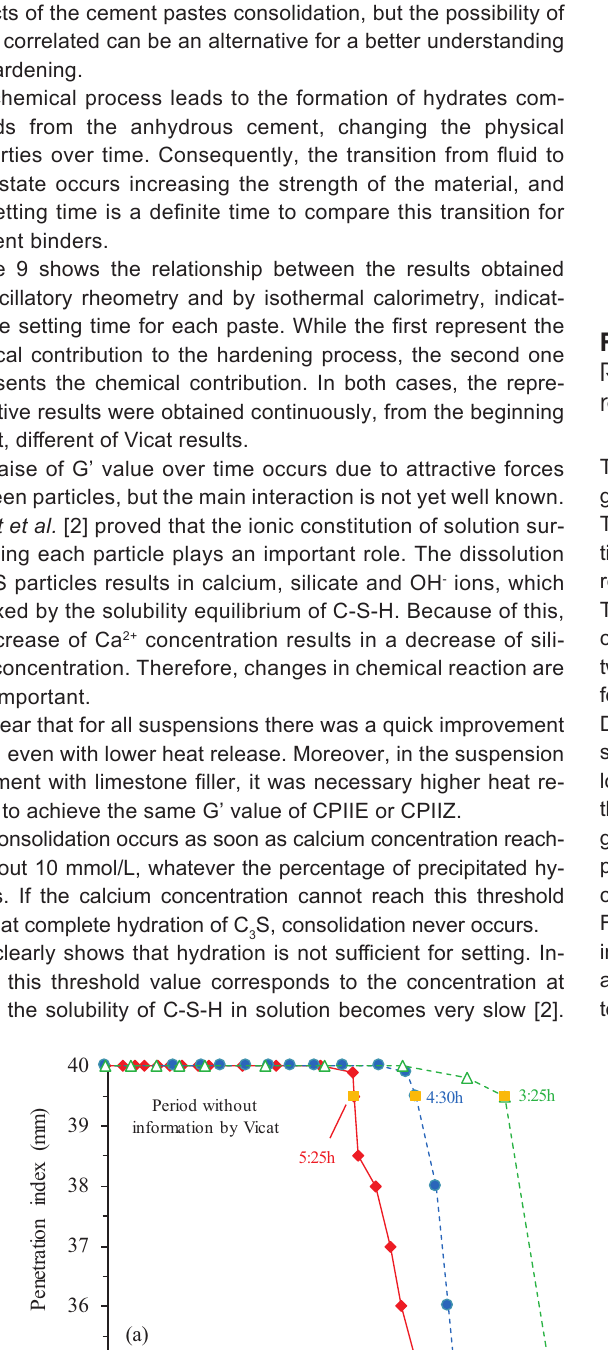
y = -0.66x + 11.05 R² = 0.54